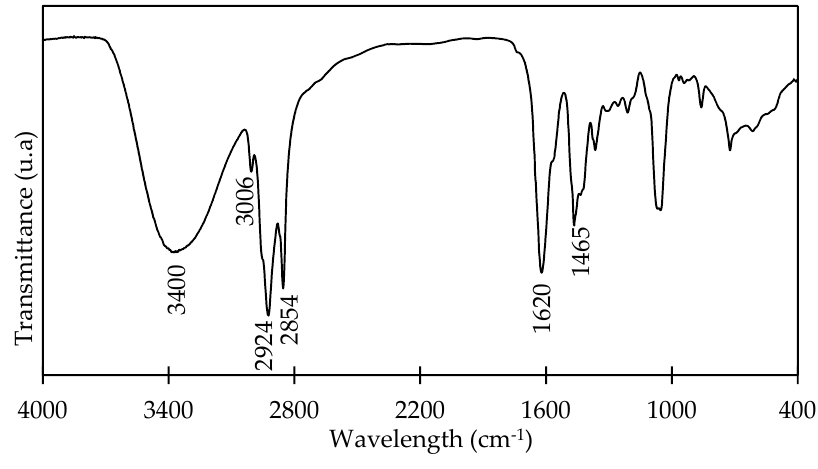
Figure 3. FTIR spectrum of OADA.